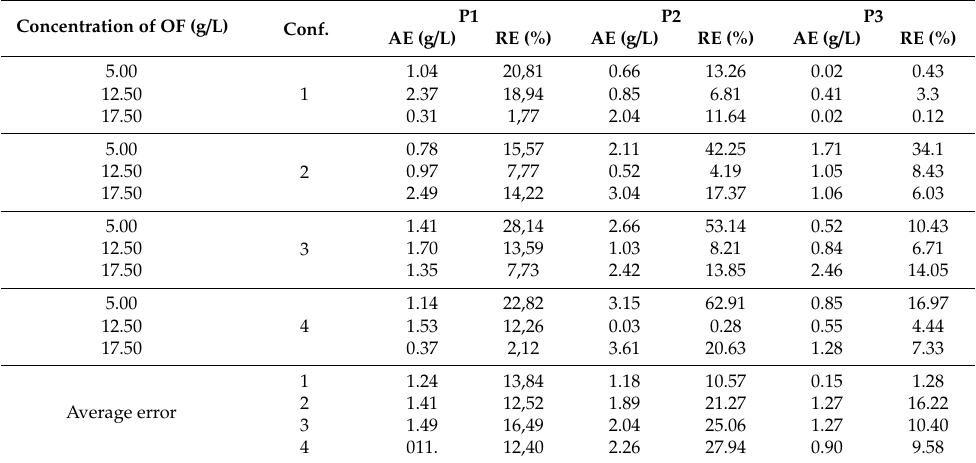
Table 5. Verification of the calibrations of the prototypes. Abbreviations: Absolute Error (AE) and Relative Error